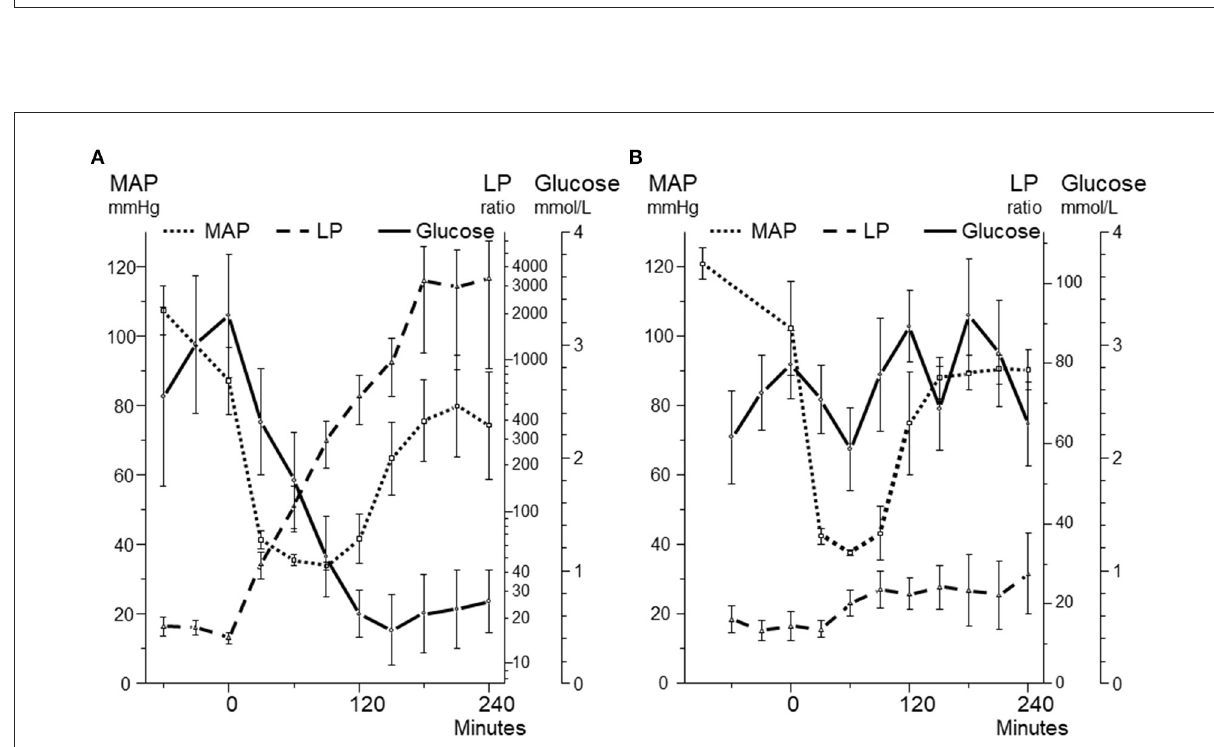
FIGURE9 Mean arterial blood pressure (MAP) and intracerebral levels of glucose and lactate/pyruvate (LP) ratio during 240min before, during and after a 90min period (A) and a 60min period (B) of hemorrhagic shock. In both panels MAP decreased to 40 mmHg. Panel A illustrates the biochemical pattern during severe cerebral ischemia. Panel B illustrates a pattern when intracerebral glucose an LP ratio are relatively unaffected during a similar but shorter decrease in MAP. Data from (94, 95) are shown as Mean ±